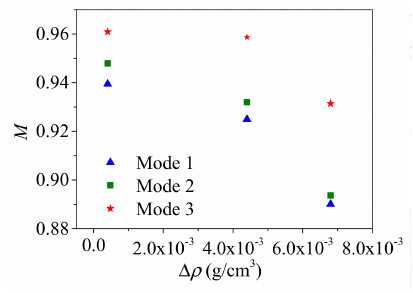
Figure 11. Merit factor of the microsphere for di ff erent modes.